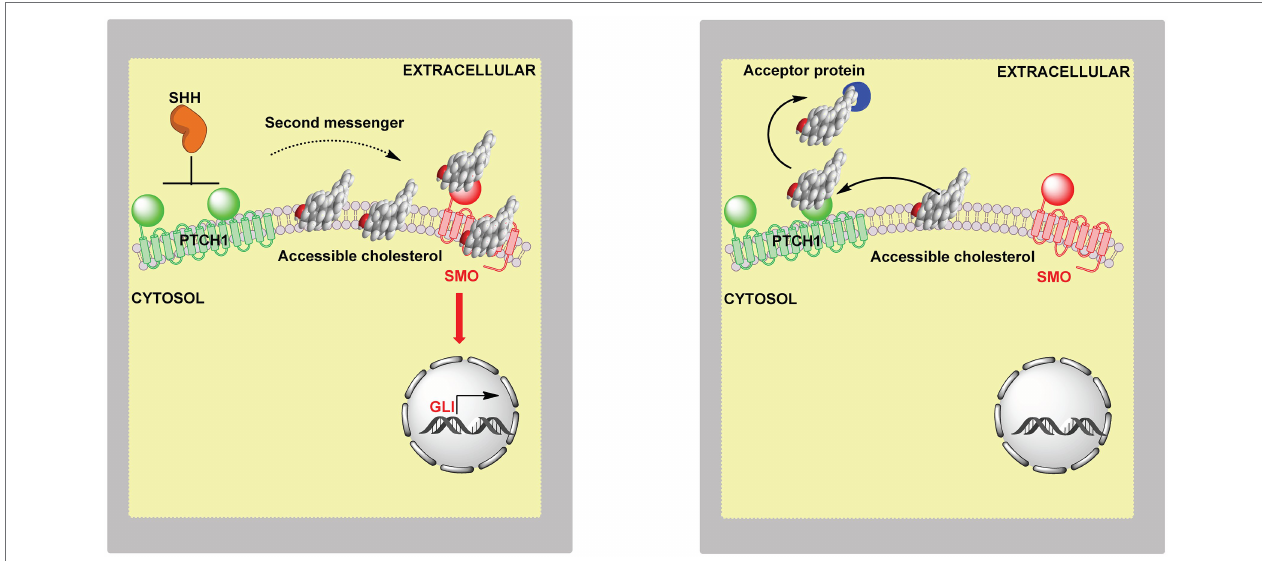
FIGURE 15 | Cartoon representation of the involvement of accessible cholesterol in Hh signalling. Left panel , extracellular SHH binds to PTCH1 on the cilium membrane, SMO is activated and GLI transcription factors activate GLI target genes. When SHH binds to PTCH1 it inhibits the action of PTCH1, this may lead to accumulation of accessible cholesterol which acts as the second messenger between PTCH1 and SMO. Cholesterol can bind to the CRD and TMD of SMO, binding at both sites may be required for maximal activation. Right panel , the “pump leak” model proposes PTCH1 acts as a sterol pump removing sterols from